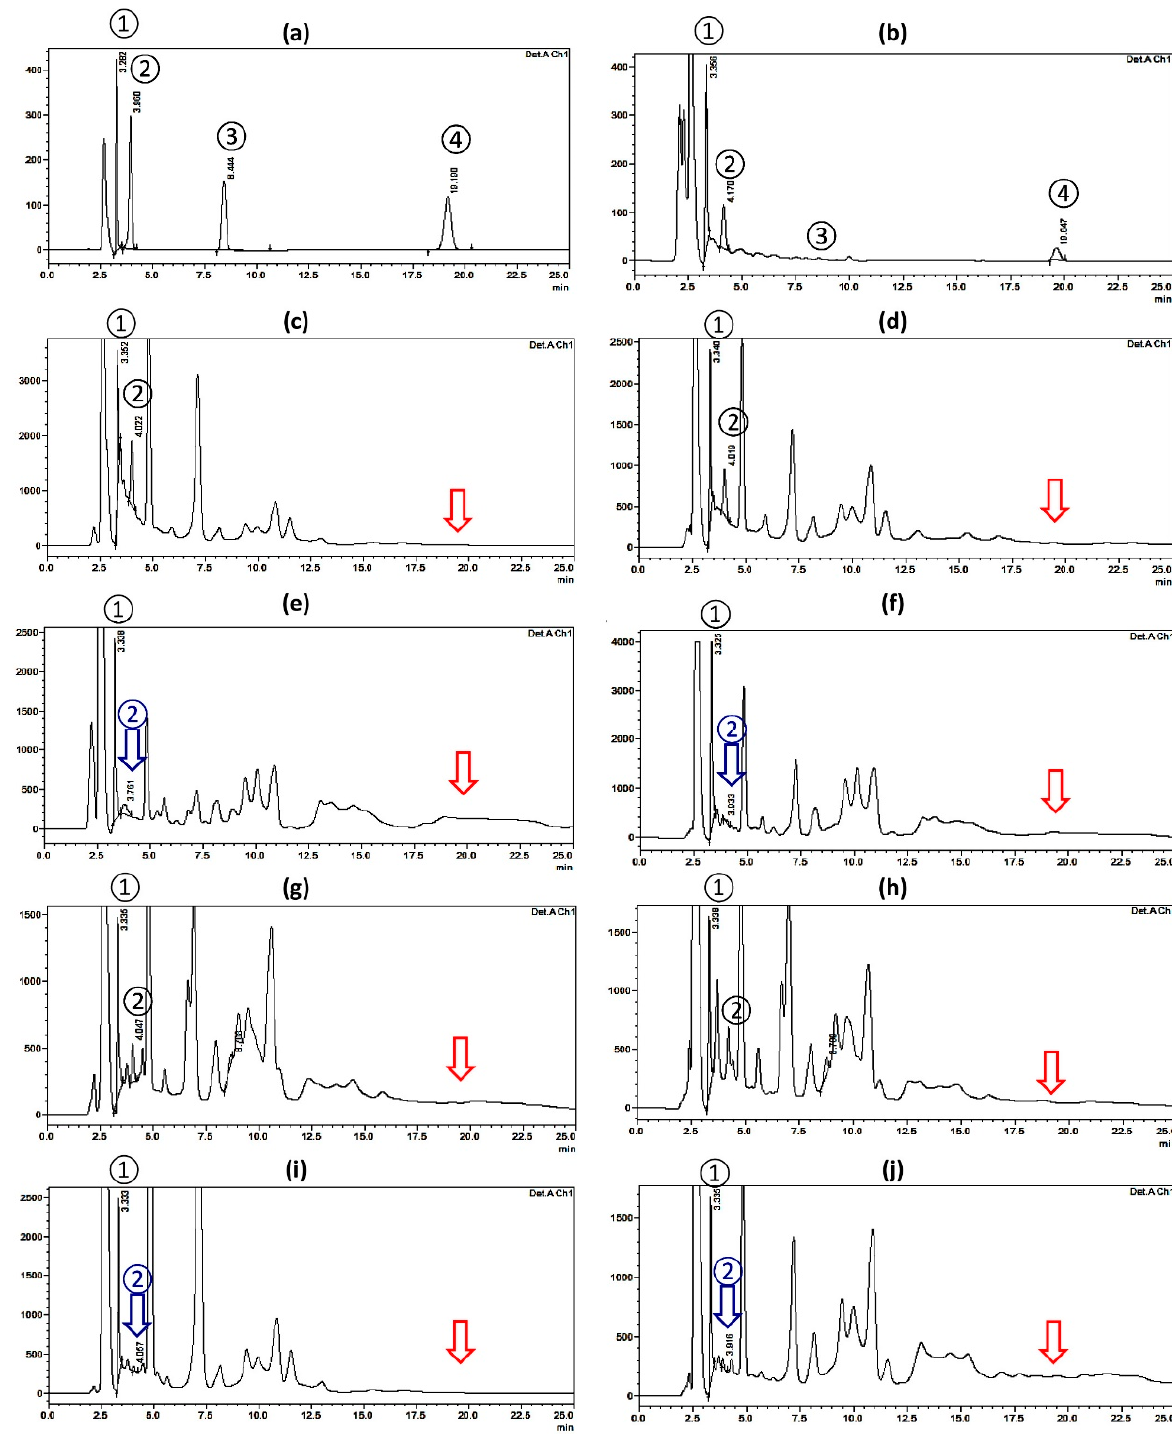
Figure 3. HPLC-UV chromatograms (at 210 nm) on a RP-C 18 column with reference standards peaks; ( 1 ) Gallic acid, ( 2 ) Catechin, ( 3 ) Scoploletin, and ( 4 ) Umckalin. ( a ) Mixture of reference standards biomolecules; and different plant extracts at a concentration of 10 mg/mL of; ( b ) Pelargonium sidoides root extract, ( c ) Pelargonium × hortorum with pink flowers (PPH) root, ( d ) Pelargonium × hortorum with white flowers (WPH) root, ( e ) PPH flower, ( f ) WPH flower, ( g ) PPH leaf, ( h ) WPH leaf, ( i ) PPH stem, and ( j ) WPH stem. The blue arrows refer to undetected catechin peaks and the red arrows refer to undetected umckalin peaks.